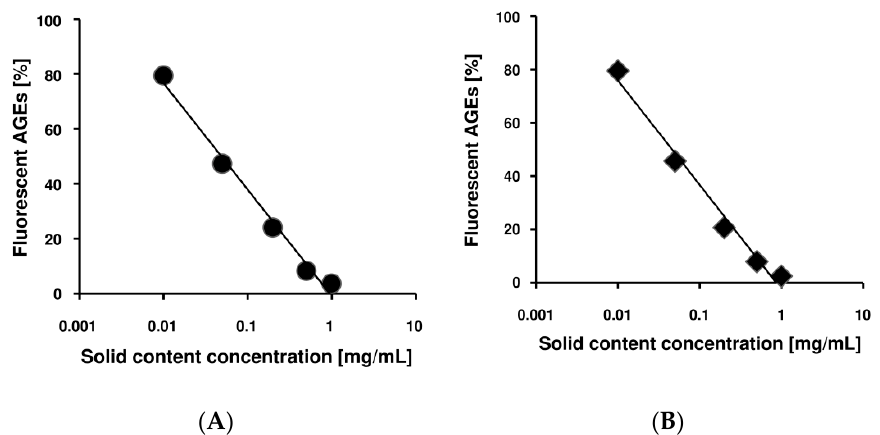
Figure 1. Effect of Persicaria hydropiper extracts on formation of fluorescent advanced glycation end products (AGEs). P. hydropiper extract of either ( A ) water or ( B ) 70% ( v / v ) ethanol (EtOH) was introduced into the human serum albumin (HSA) glycation models at the indicated solid-content concentrations. After 40 h incubation at 60 °C, fluorescent AGEs were measured at 370/440 nm.